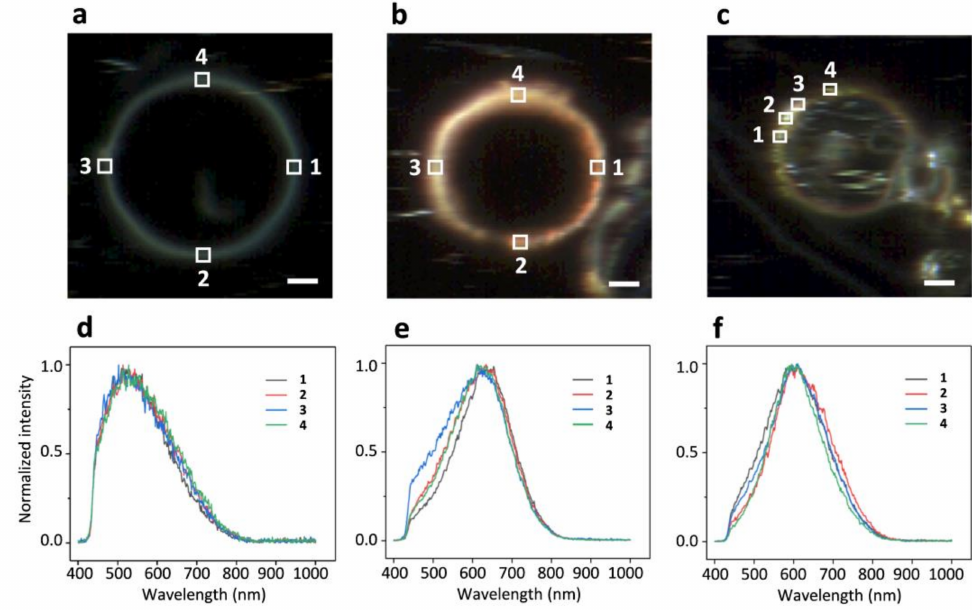
Figure 3. DFM images ( a ) GUV alone, ( b ) AuNPs and GUVs, as well as ( c ) AgNPs and GUVs. The GUVs shown here are made of 20 mol% CHOL:DMPC. ( d – f ) are the normalized spectral profiles averaged from inside of the squared regions in images ( a – c ), respectively. Scale bars are 5 µ m.